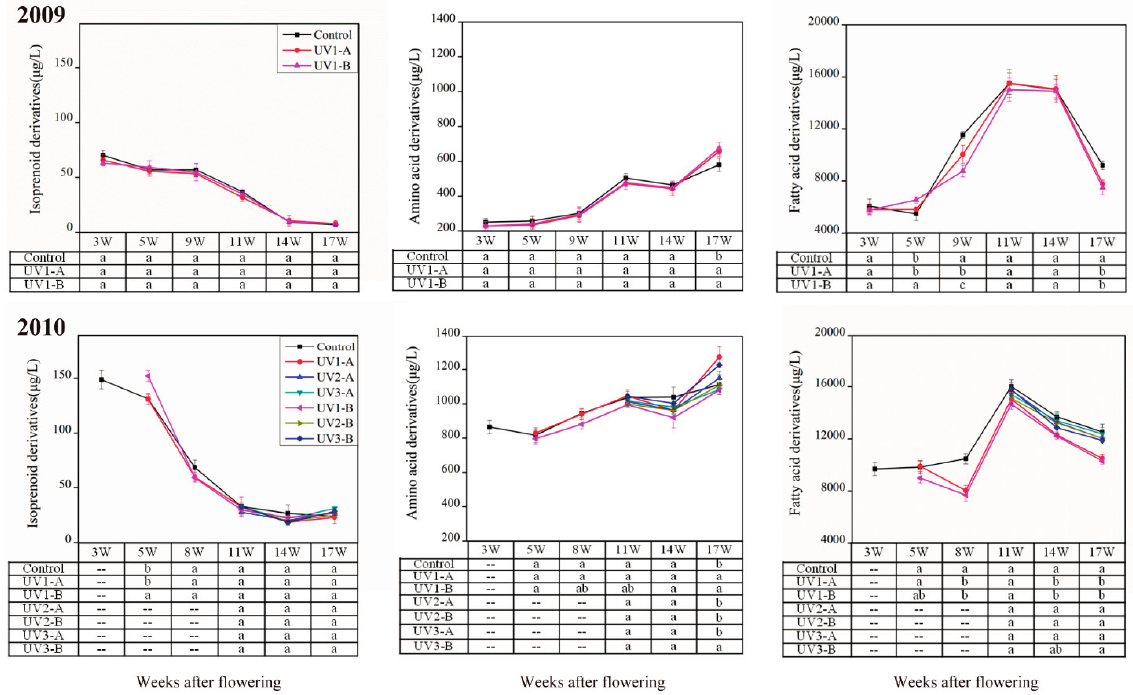
Figure 2. Effect of the attenuated UV radiation on the concentration of three major classes of volatiles in developing “Cabernet Sauvignon” grapes. The abbreviation of UV treatments are described in the “Experimental section”. Data are means ± SE of three replicates ( n = 3). At the same development stage, different letters represent significant difference among treatments ( p ≤